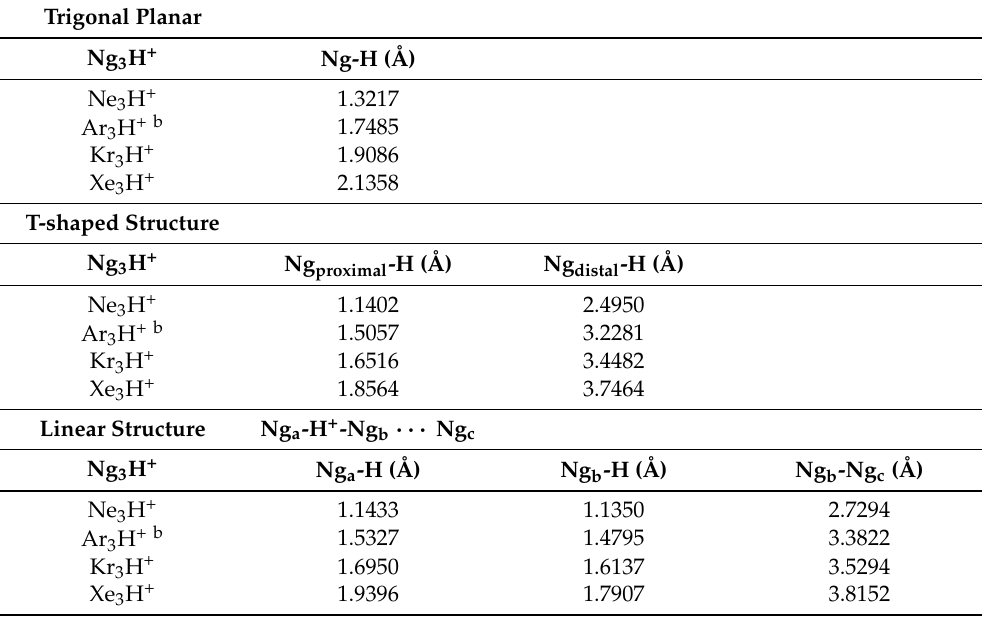
Table 6. CCSD(T)/aug-cc-pVTZ a structural parameters for Ng 3 H +